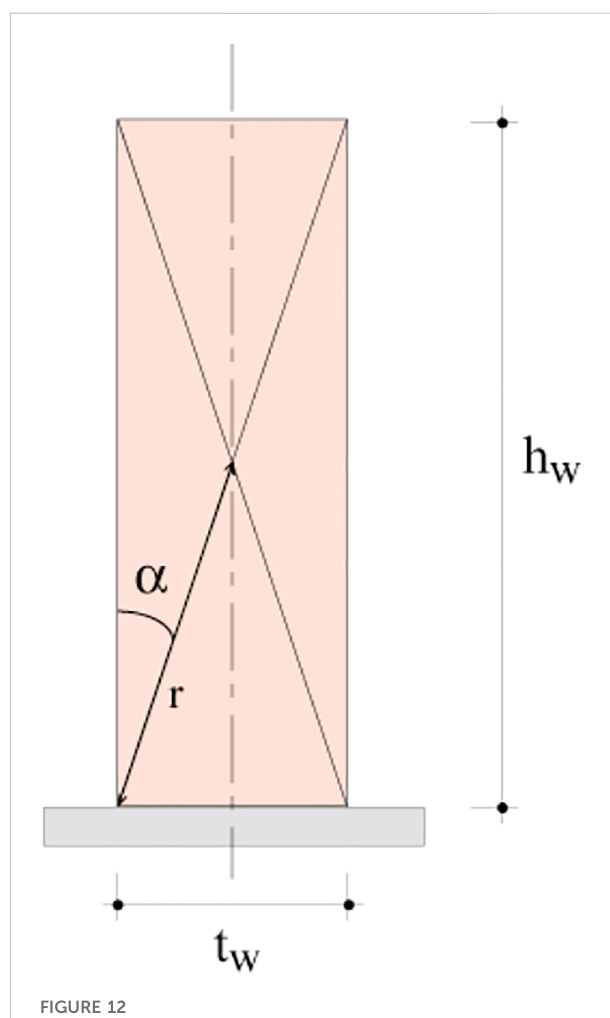
FIGURE 12 Dimension notations for the cantilever